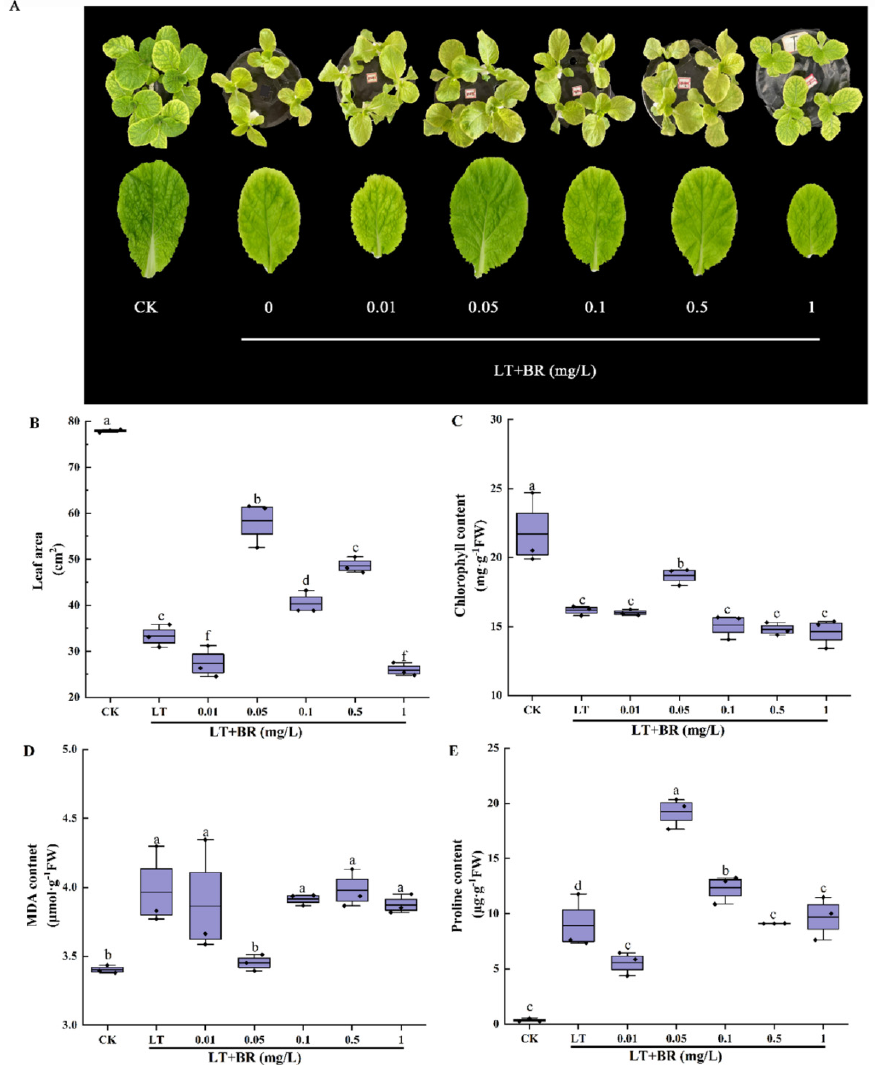
Figure 1. Effects of different concentrations of BR on the phenotype, leaf area, chlorophyll content, MDA and proline content of mini Chinese cabbage under low-temperature stress. Five-leaf seedlings were treated with CK (26/18 °C, day/night), LT (4/4 °C, day/night) and different concentrations of BR (0, 0.01, 0.05, 0.1, 0.5 and 1.0 mg/L) under low-temperature conditions. The leaves were sprayed with BR once a day for 3 d and treated for 7 d. After 7 days, leaf area, chlorophyll content, MDA and proline contents were measured, respectively. ( A ) Phenotype and leaf size of the third leaf from outside to inside after treating for 7 d; ( B ) Leaf area of the third leaf from outside to inside; ( C ) Chlorophyll content; ( D ) MDA content; ( E ) Proline content. Different lowercase letters above the error bars indicate significant differences at the 0.05 level ( p ≤ 0.05).